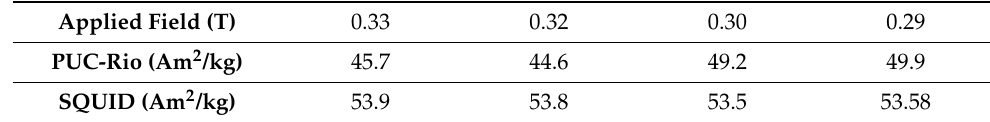
Table 2. Magnetization values in Am 2 /kg for each applied magnetic field.